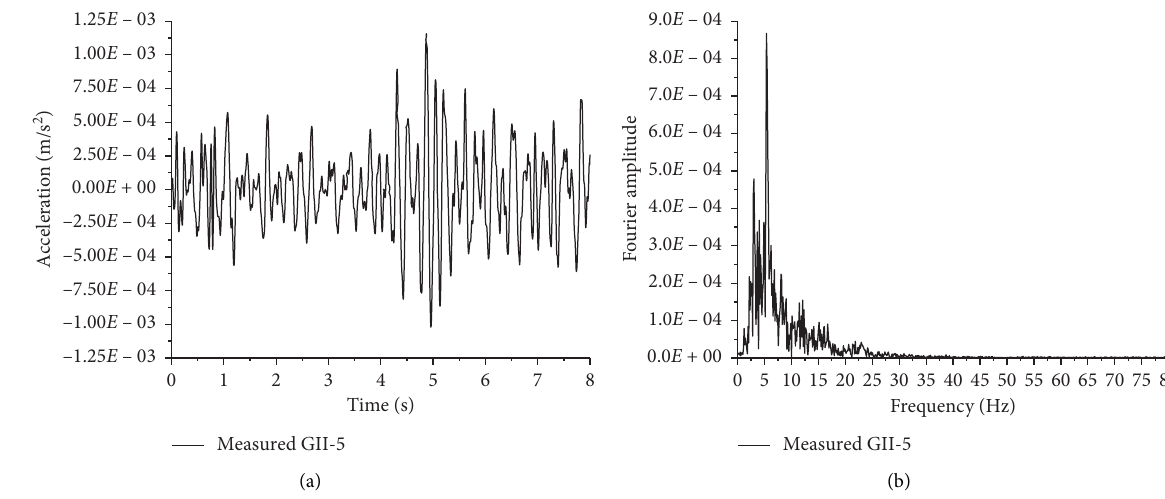
Figure 10: Acceleration: (a) time history and (b) frequency spectrum of GII-5.